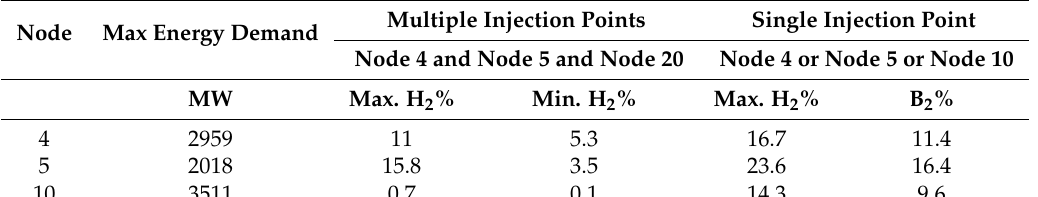
Table 3. Hydrogen concentration at three different nodes comparing the variation in H2% which occurs when the same quantity of hydrogen from curtailed wind is spread across multiple injection points or injected into one single injection point.